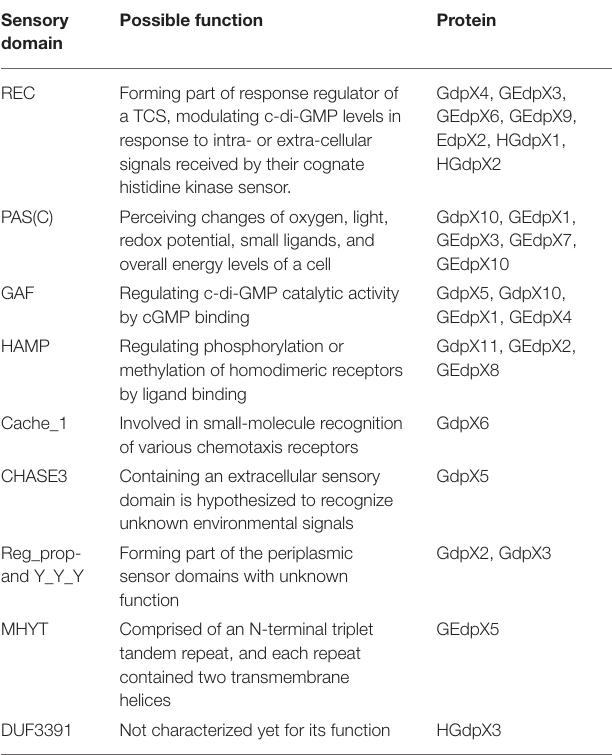
TABLE 2 | Bioinformatic analysis of sensory domains of GdpXs, EdpXs, GEdpXs and HGdpXs in Xanthomonas oryzae pv. Oryzae . Sensory